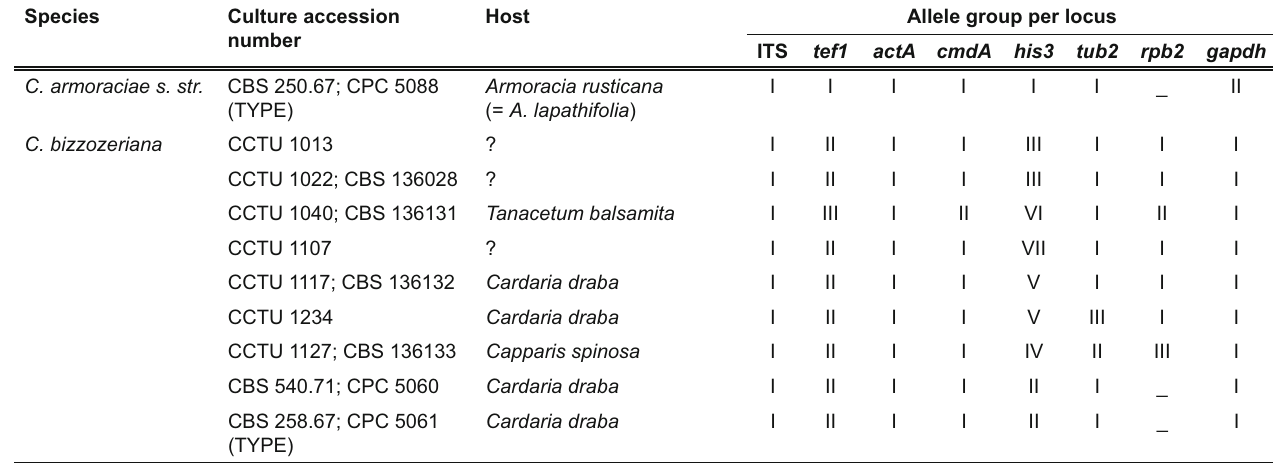
Table 6. G(cid:13)(cid:7)(cid:5)(cid:23)(cid:8)(cid:7)(cid:2)(cid:26)(cid:10)(cid:4)(cid:6)(cid:2)(cid:9)(cid:23)(cid:23)(cid:13)(cid:23)(cid:13)(cid:2)(cid:25)(cid:10)(cid:4)(cid:5)(cid:18)(cid:2)(cid:21)(cid:13)(cid:7)(cid:11)(cid:25)(cid:17)(cid:9)(cid:8)(cid:11)(cid:4)(cid:17)(cid:2)(cid:18)(cid:13)(cid:10)(cid:2)(cid:23)(cid:4)(cid:19)(cid:5)(cid:7)(cid:2)(cid:26)(cid:4)(cid:10)(cid:2) Cercospora armoraciae s. lat. (cid:11)(cid:7)(cid:4)(cid:23)(cid:9)(cid:8)(cid:13)(cid:7)(cid:2)(cid:11)(cid:17)(cid:2)(cid:8)(cid:14)(cid:11)(cid:7)(cid:2)(cid:7)(cid:8)(cid:5)(cid:21)(cid:22)(cid:28)(cid:2)/(cid:12)(cid:12)(cid:10)(cid:13);(cid:11)(cid:9)(cid:8)(cid:11)(cid:4)(cid:17)(cid:7)(cid:2)(cid:4)(cid:26)(cid:2)(cid:23)(cid:4)(cid:19)(cid:11)(cid:2)(cid:9)(cid:17)(cid:21)(cid:2) (cid:19)(cid:4)(cid:23)(cid:23)(cid:13)(cid:19)(cid:8)(cid:11)(cid:4)(cid:17)(cid:2)(cid:9)(cid:19)(cid:19)(cid:13)(cid:7)(cid:7)(cid:11)(cid:4)(cid:17)(cid:2)(cid:17)(cid:5)(cid:6)(cid:12)(cid:13)(cid:10)(cid:7)(cid:2)(cid:26)(cid:4)(cid:23)(cid:23)(cid:4)(cid:15)(cid:2)<(cid:9)(cid:12)(cid:23)(cid:13)(cid:2)!(cid:28) Species Culture accession Host Allele group per locus number ITS tef1 actA cmdA his3 tub2 rpb2 gapdh C. armoraciae s. str. %’7(cid:2)*0+(cid:28)$#K(cid:2)%=%(cid:2)0+33(cid:2) Armoracia rusticana (cid:24)<(cid:3)=(cid:31)(cid:27) (= A. lapathifolia ) C.